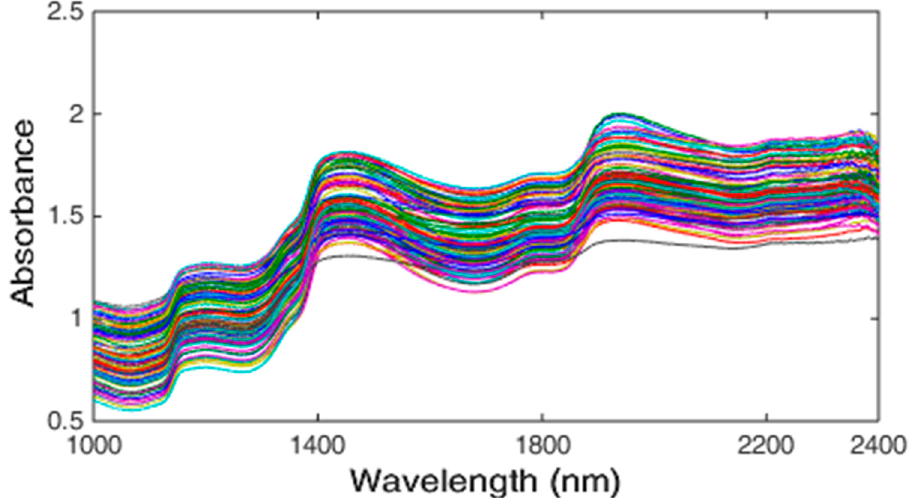
Figure 1. Raw near-infrared (NIR) spectra (1000–2400 nm) of intact acerola fruit.